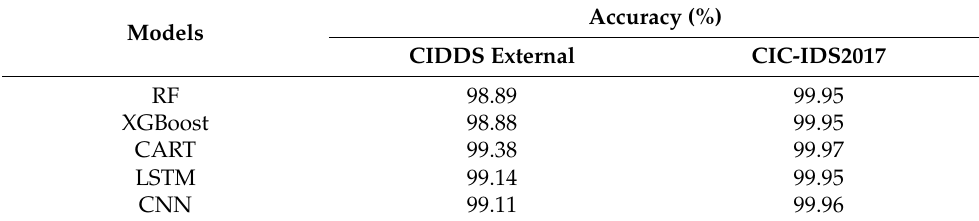
Table 8. Performance of ML and DL models on CIDDS and CIC-IDS2017 dataset.